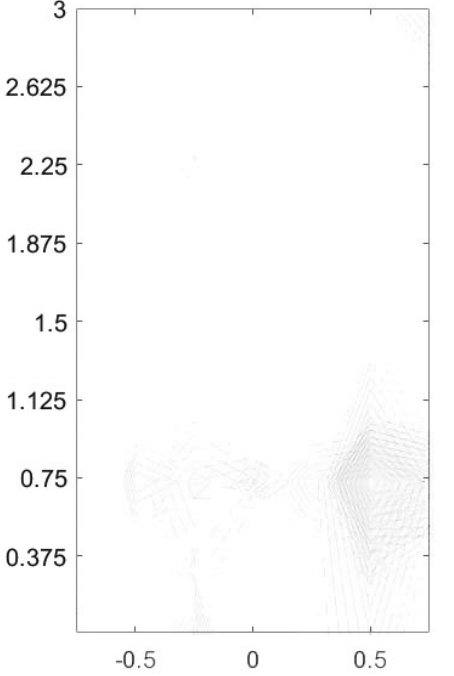
Figure 14 . Grayscale image after fusion. Figure 14. Grayscale image after